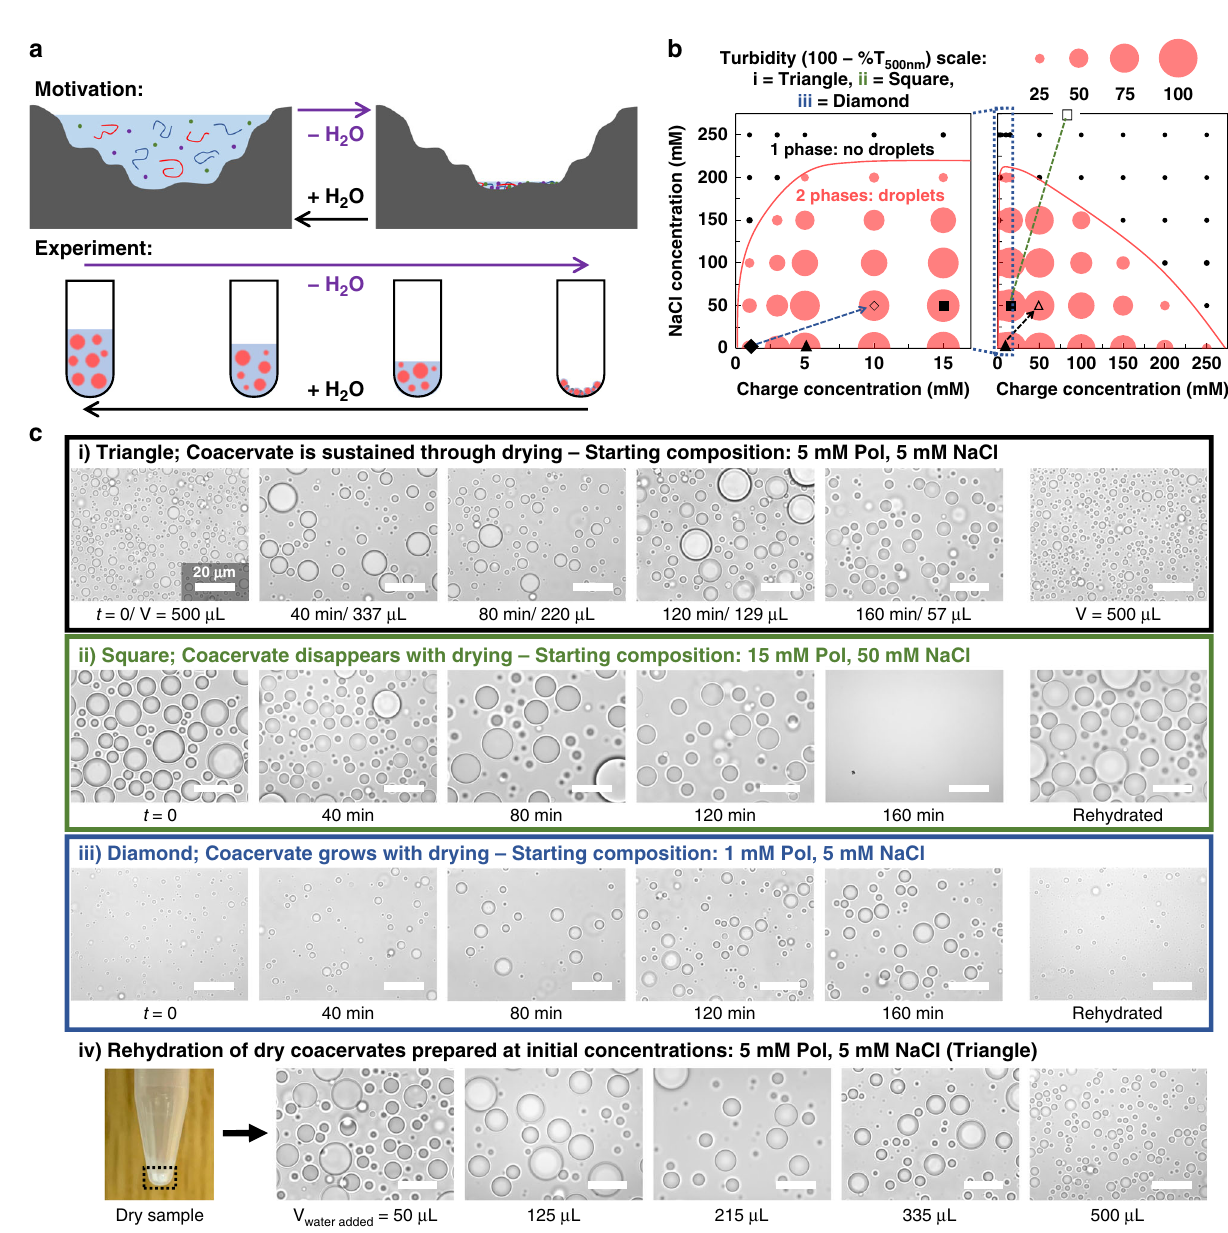
Fig. 1 Drying and rehydrating controls the formation of PDADMA/PAA complex coacervates. a Scheme showing the motivation behind the wet-dry cycle experiment — an early Earth environmental scenario proposed for the emergence of chemical complexity. b Turbidity values for 1:1 PDADMA:PAA complex coacervates prepared at different charge and salt concentrations ([monomer charge] is calculated with respect to the concentration of the polymer repeat units). All samples contained 25 mM HEPES and 4.3mM MgCl 2 . The plot on the left is a zoom-in on the low [charge] samples. Black markers represent turbidity below a cutoff of 20, which was chosen based on microscopy images (Supplementary Fig. 8). The width of all circles is proportional to the turbidity values of the overall samples (see legend above, T refers to transmittance). As a guide to the eye, a solid red line delimits the expected boundary between the two-phase and one-phase regions; the line is an approximate binodal curve. The charge concentration refers to one polymer type, not the total amount of both polymers. c Comparison between drying different 1:1 PDADMA:PAA coacervate compositions based on different starting locations on the phase diagram (i = fi lled triangle, ii = fi lled square, iii = fi lled diamond, with the open versions — open triangle, open square, open diamond — and dashed arrows showing the expected approximate 10× dehydration) in the time range of 0 – 160min. Drying was performed in a heatblock at 95°C; (i) shows the volume remaining at each time point (V), which is an average of 27 samples (see Fig. 2) and is applicable to (ii) and (iii) as they have the same drying rate. The dashed arrow in (ii) is expected to go up to 500 mM [NaCl] and 150 mM [polymer charge], and is thus not fully shown. (iv) Rehydration of (i) by adding a volume of water similar to the volume reached at each time point in reverse order of the top panel. All scale bars are 20 µ